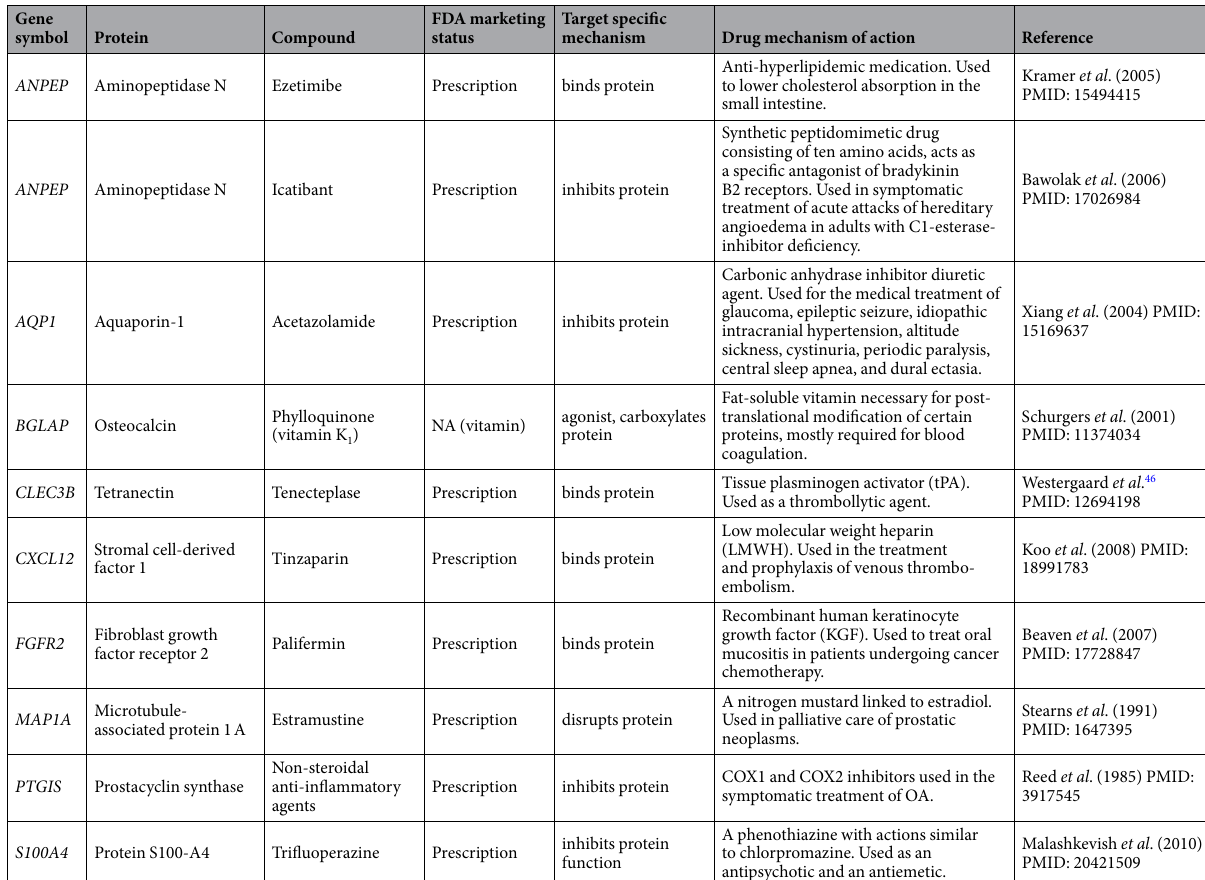
Table 1. Results of Drugbank 25 (www.drugbank.ca) search for therapeutic compounds with current